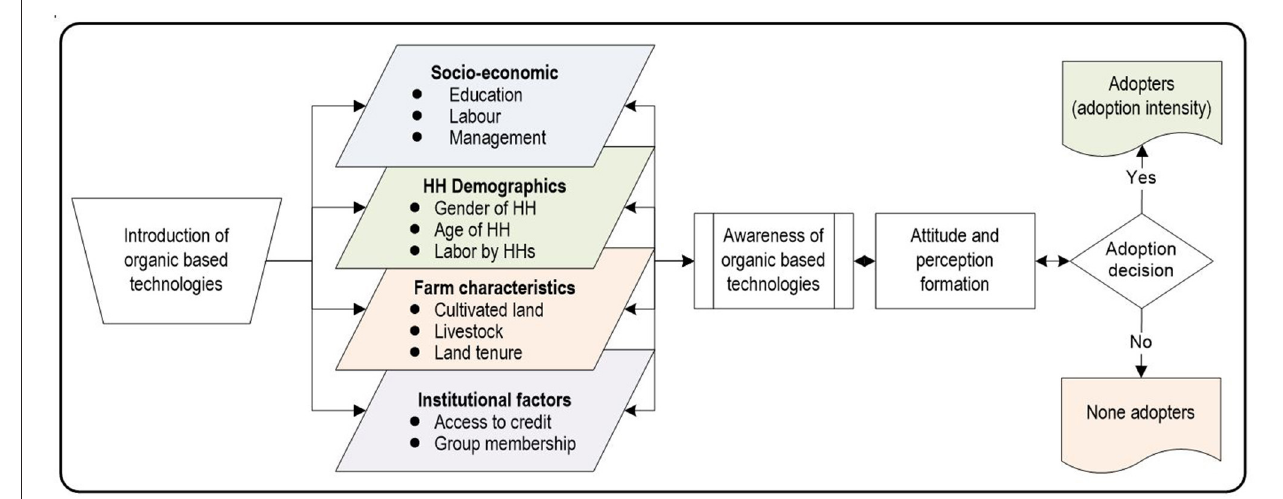
FIGURE 1 | Schematic framework for studying farmer’s adoption behavior in the Central.